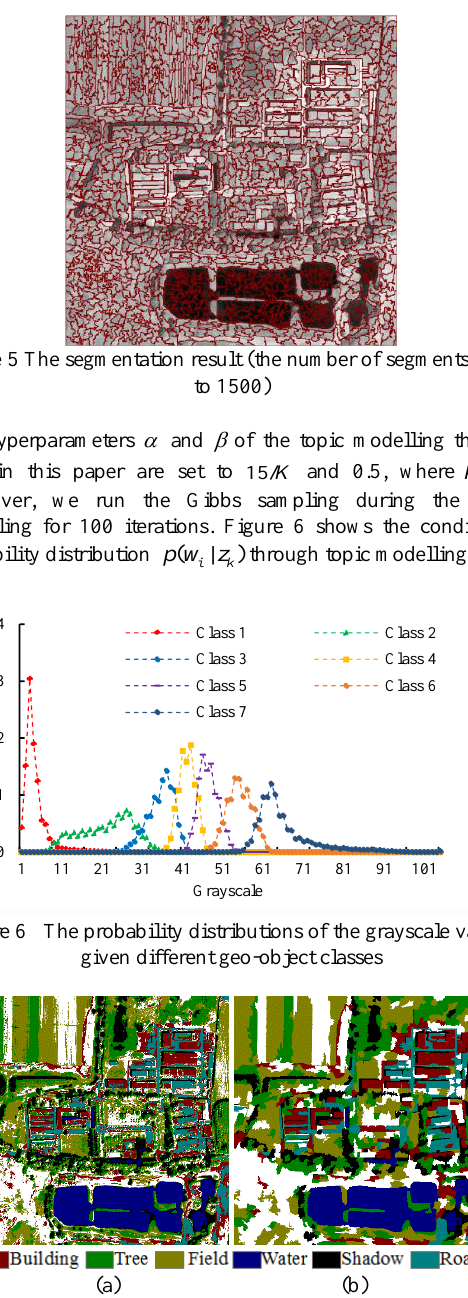
Figure 7 The classification results: (a) traditional topic modelling; (b) the proposed topic modelling Traditional